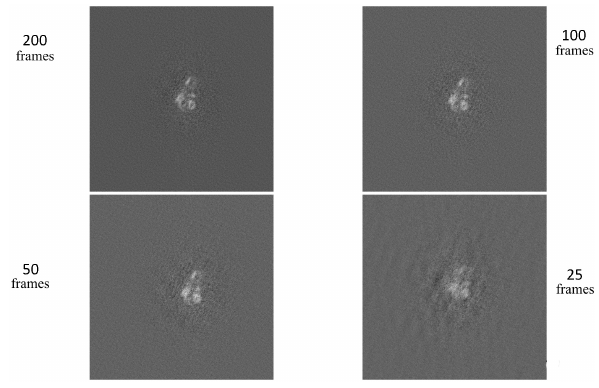
Figure 12. Restored images for photon noises (point-spread func- tions – star №1)